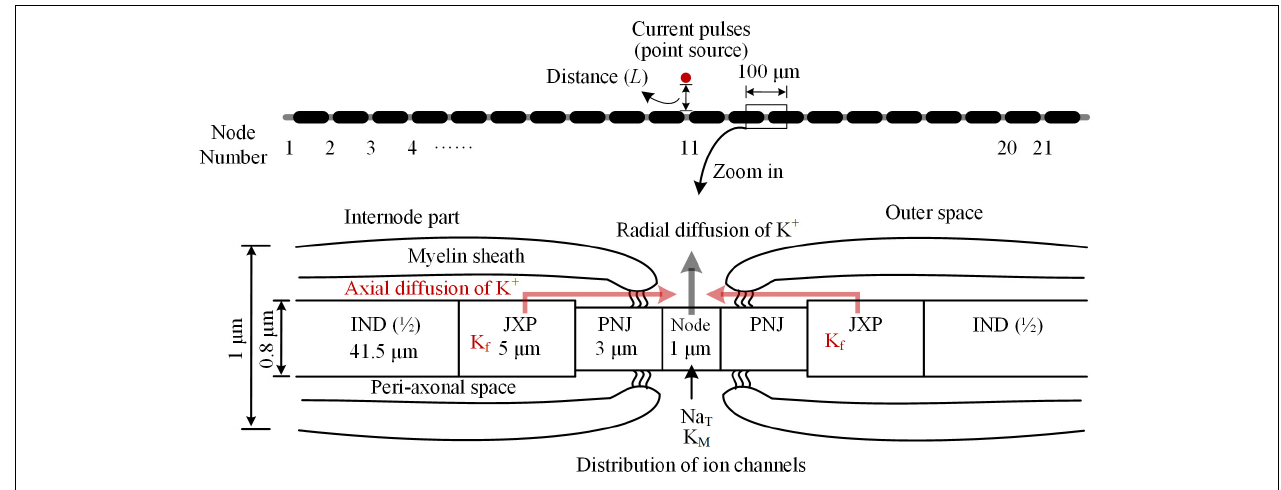
FIGURE 1 | Schematic diagram of the model for thin myelinated axon, including structures, dimensions, and distributions of ionic channels. Top : Overview of the entire axon with 21 nodes of Ranvier (Node) and 20 internode parts. Bottom : Magnified view of a nodal region with the three sections surrounding each node: paranodal junction (PNJ), juxtaparanodes (JXP), and internode (IND). Axial and radial diffusion of K + are shown by pink and gray arrow-lines, respectively.